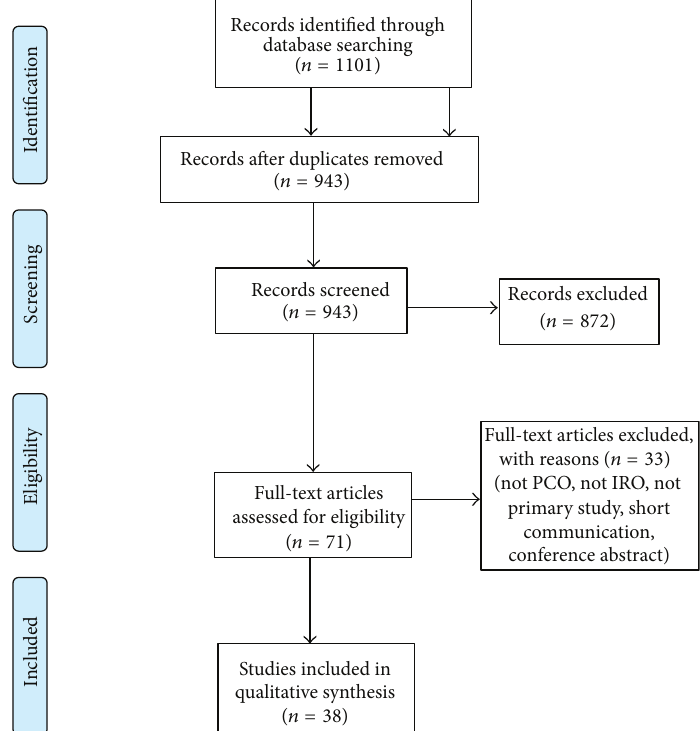
Figure 1: Study selection following PRISMA